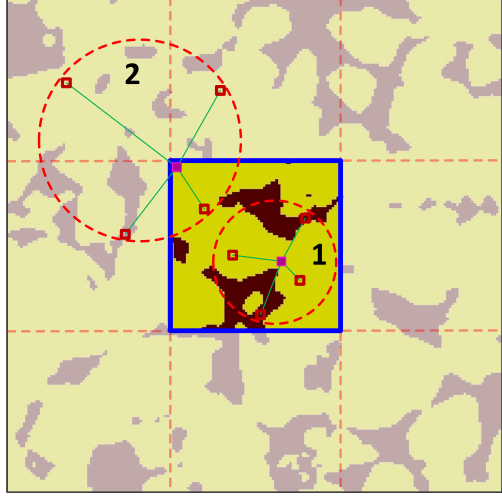
Figure 2. Search window in